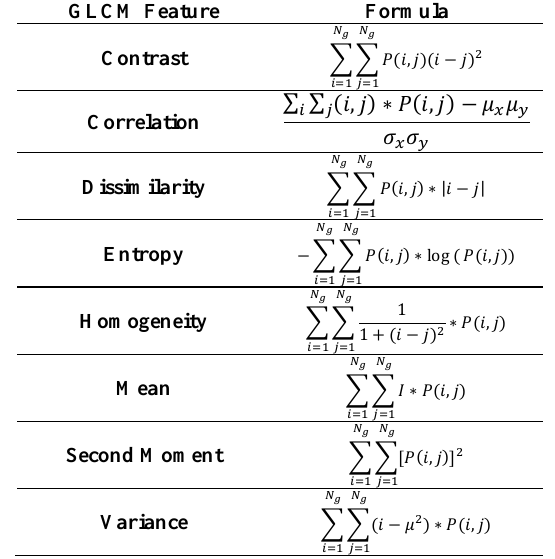
Table 2. GLCM features used in the